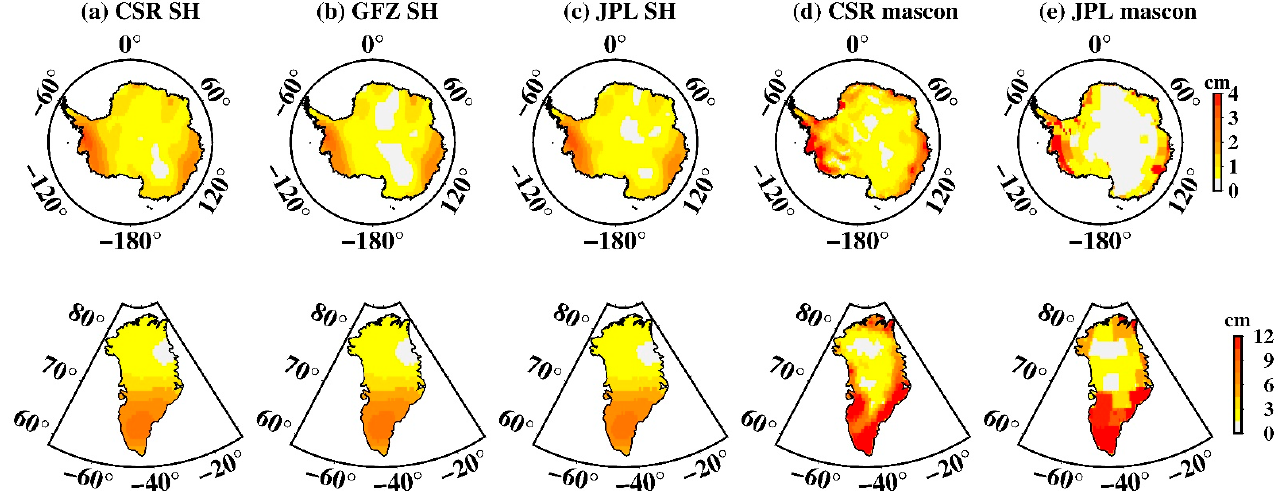
Figure 14. Annual oscillation over Antarctica and Greenland. ( a ) CSR SH data, ( b ) CSR mascon data, ( c ) JPL mascon data, ( d ) CSR mascon data, ( e ) JPL mascon data.